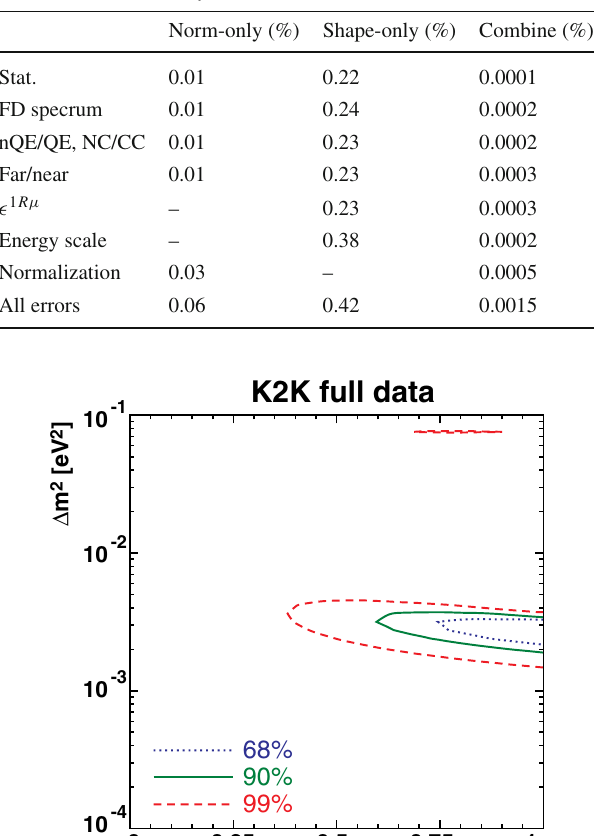
Table 12 Effect of each systematic uncertainty on the null oscillation probability. The numbers in the table are null oscillation probabilities with only the systematic uncertainty in the first column applied, and “stat” means when all systematic sources are turned off